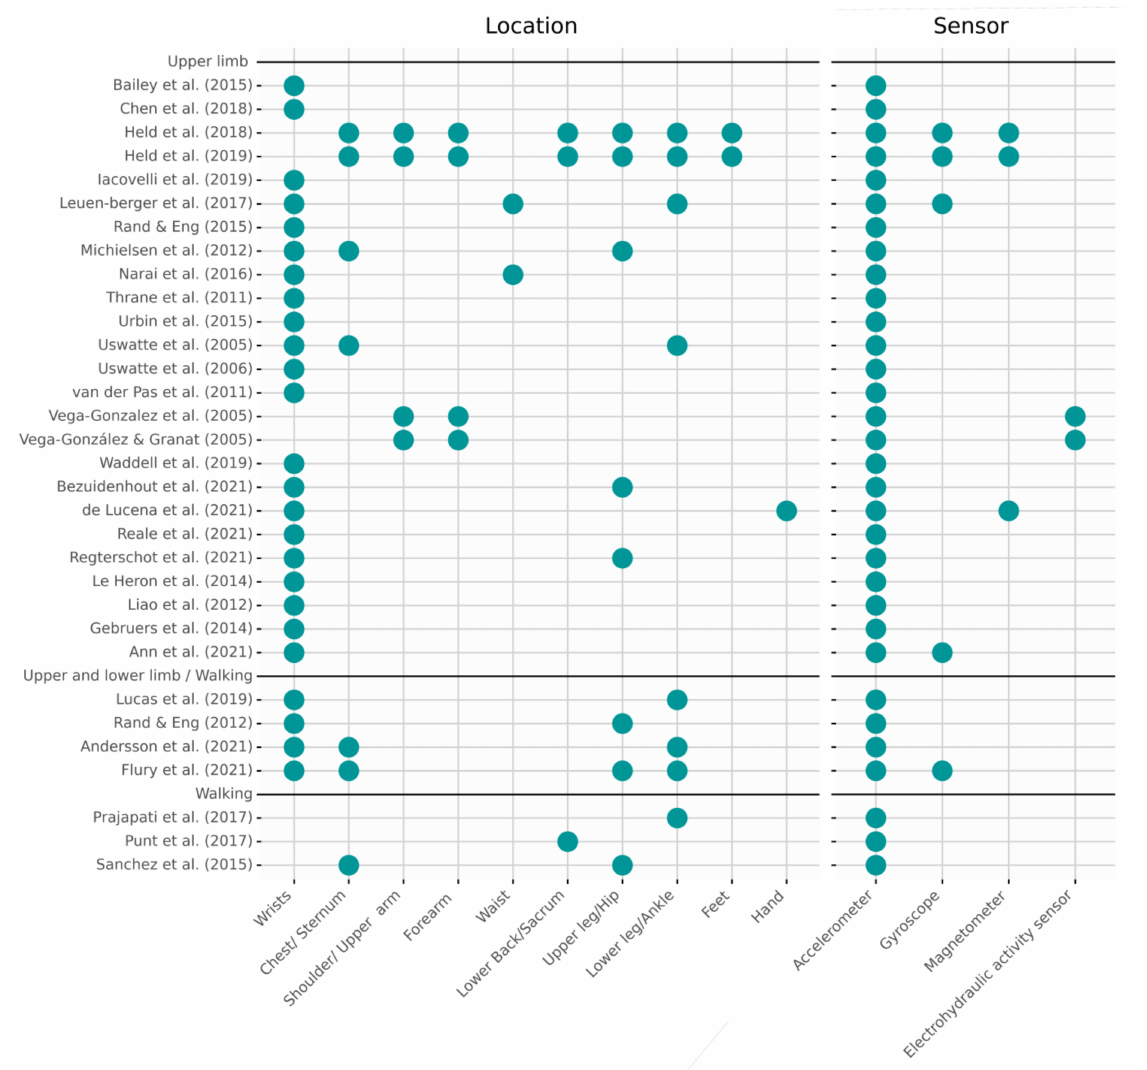
Figure 2. Sensor technology and locations. Overview of the locations of the sensors and type of sensors used in the included studies, separated by the focus of the study. Note that several upper limb studies include sensors on other parts of the body, but these are not used in the analysis or are used for secondary purposes, such as activity recognition or development of a kinematic model of the body